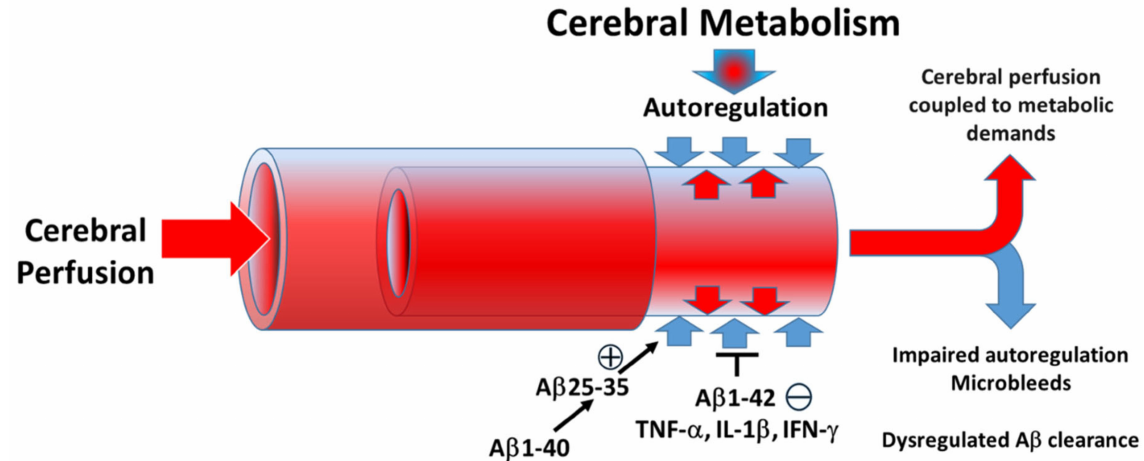
Figure 5. Disturbances in autoregulation produced by A β 1-42 and inflammatory cytokines (TNF- α , IL-1 β and IFN- γ ) could lead to impaired ( − ) cerebral perfusion and contribute to microbleeds and dysregulated A β clearance. A β 25-35 may enhance constriction (+). We were unable to observe effects of A β 1-40 on human brain smooth muscle